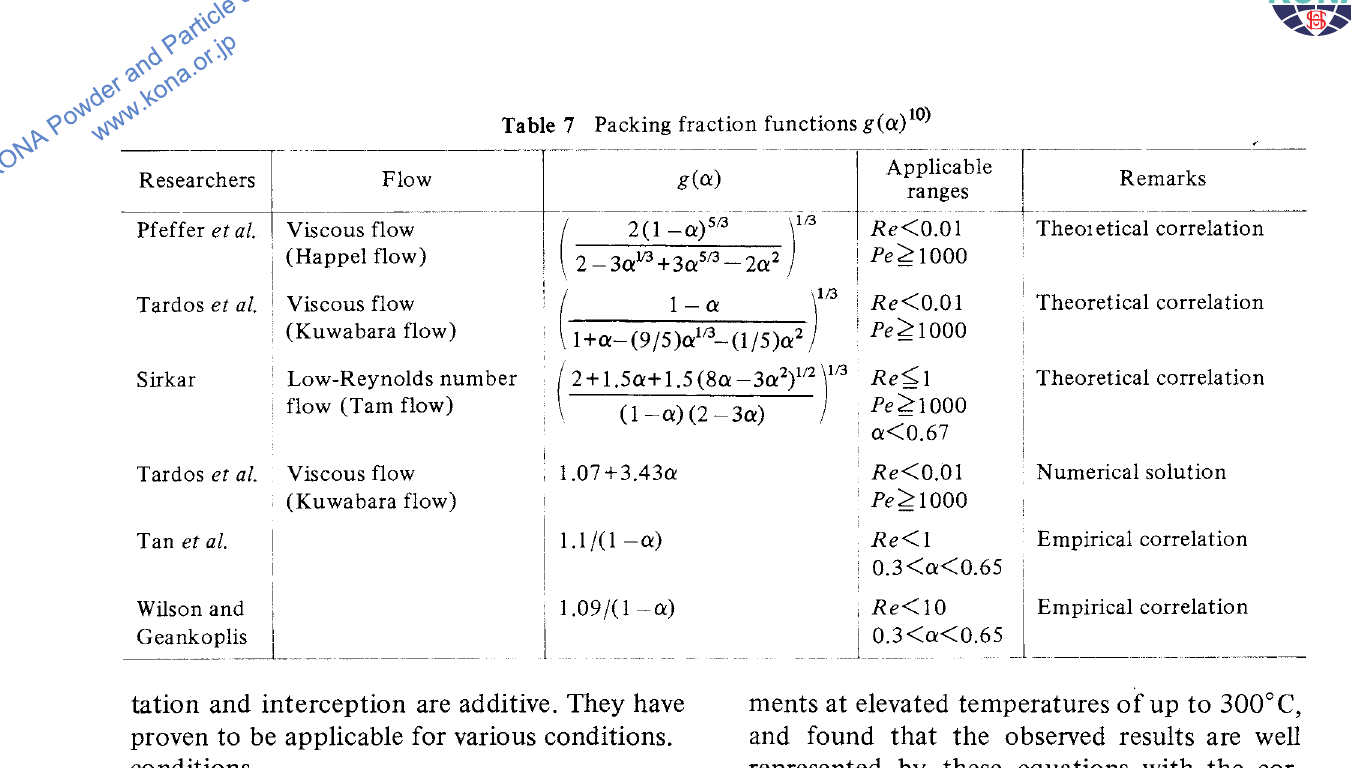
Table 7 Packing fraction functions g(a:) 10